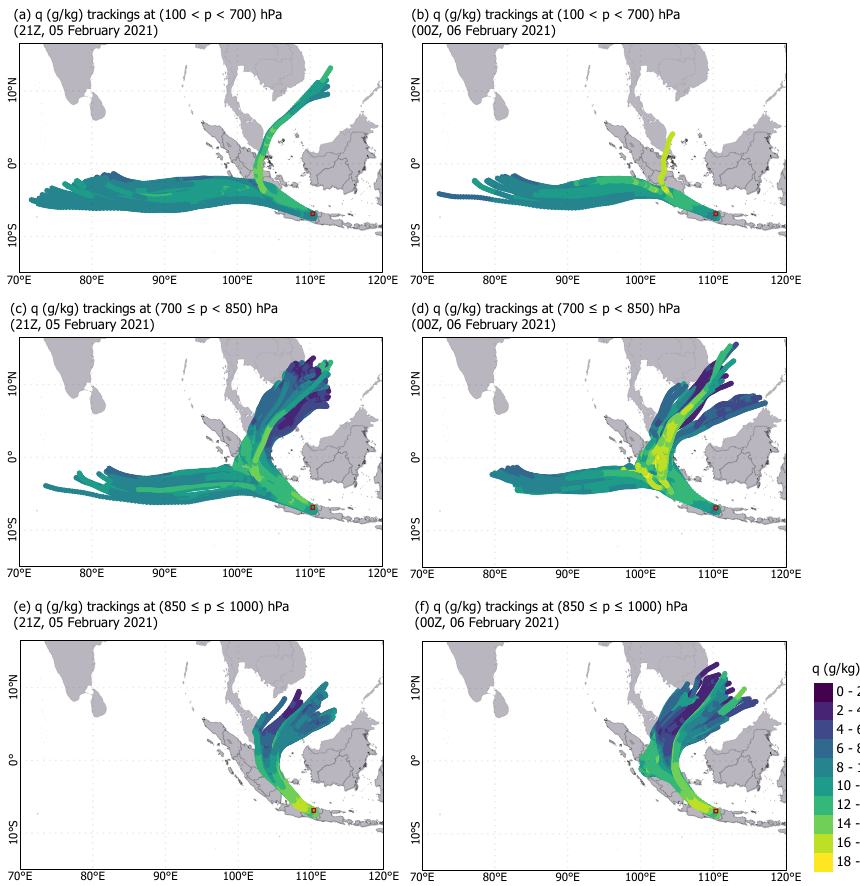
Figure 4. Characteristics of moisture transport prior to and during the period of maximum precip- itation events in Semarang. The 72-hr backward moisture trajectories (lines) of the two peaks of precipitation events: ( a , c , e ) 21Z 05 February 2021 and ( b , d , f ) 00Z 06 February 2021 are shown at the three different layers: ( a , b ) (100 < p < 700) hPa, ( c , d ) (700 ≤ p < 850) hPa, and ( e , f ) (850 ≤ p ≤ 1000) hPa. Colors on the pathways indicate the average specific humidity of air parcels along the trajectories (g/kg). The location of Semarang is denoted by a red